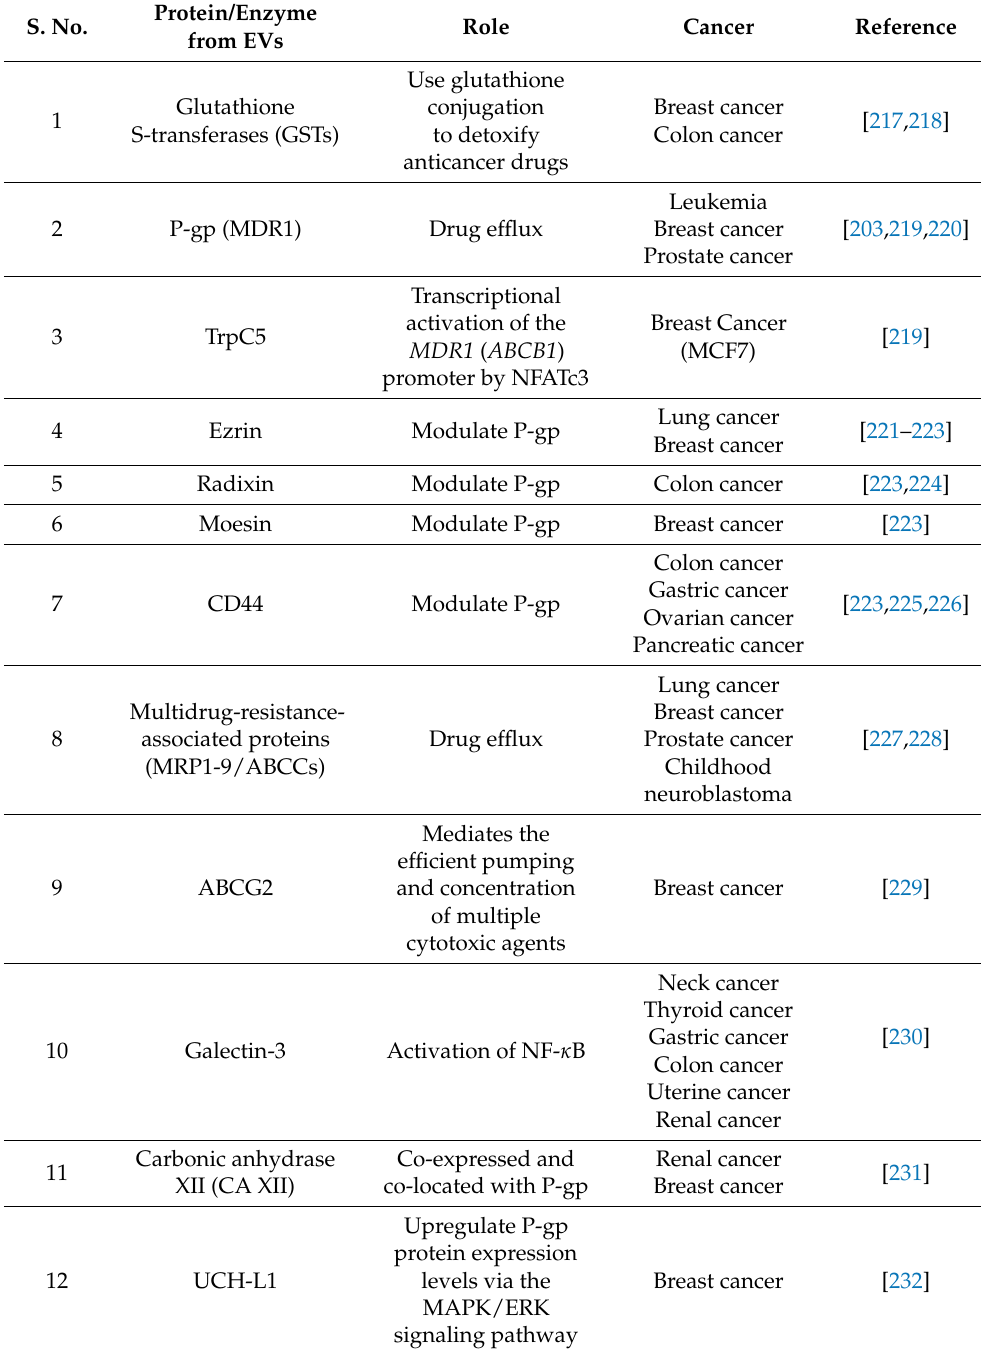
Table 3. List of proteins/enzymes from EVs and their role in cancer drug resistance. S.